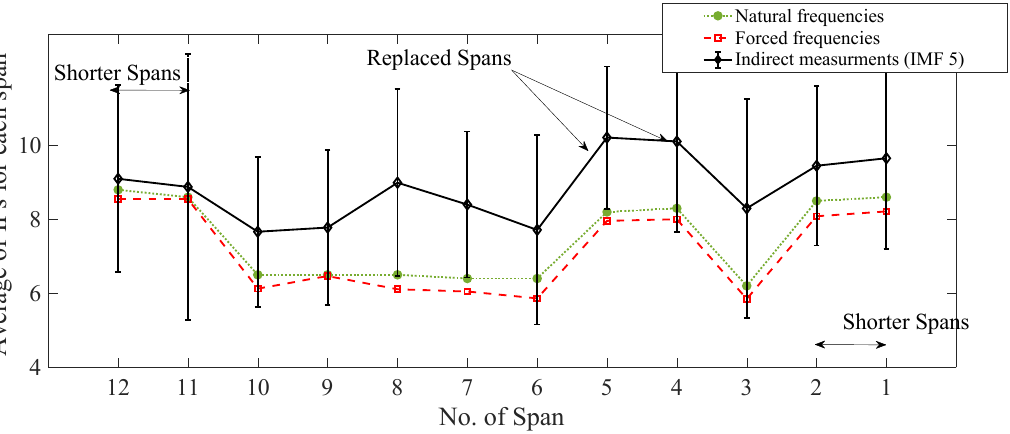
Figure 14. Averaged IFs of each Span (from IMF 5) from the indirect measurements (compared to the direct measurements).